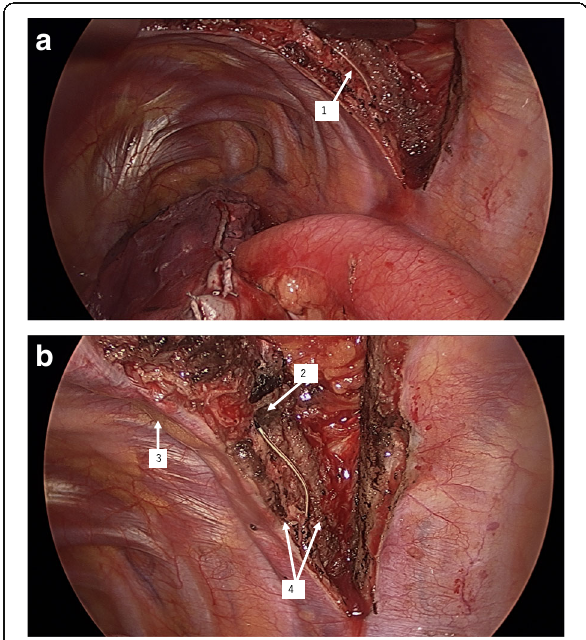
Fig. 1 a , b The epidural catheter is seen 3 cm from the dorsal edge of the posterolateral incision at the Th 5 – 6 intercostal space. Arrow 1, the epidural catheter was found between the innermost and internal intercostal muscles, below the fifth rib. It seemed to run along with the intercostal nerve. Arrow 2, tip of the catheter. Arrow 3, fifth rib. Arrow 4, the innermost and internal intercostal